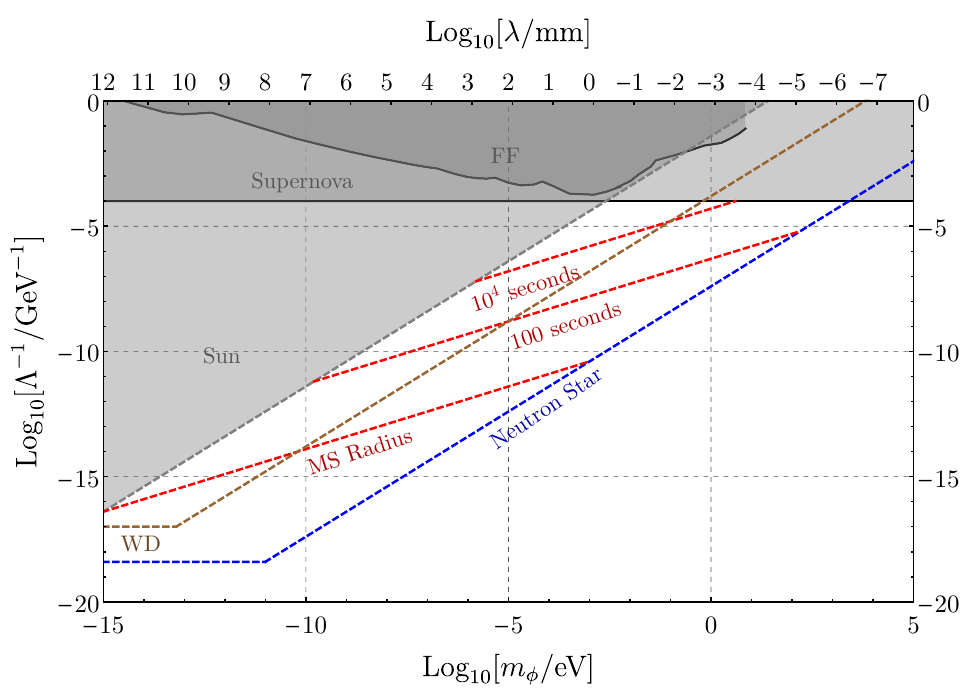
Figure 3 . Parameter space of scalars which interact with nucleons as φ 2 are excluded by supernova [51], measurements of solar neutrinos [31], and fifth-force measurements (see [52] and references within). Bubbles can be launched by a neutron star in the region to the left of the neutron star line (blue dashed). The bubbles will expand to a size with roughly main sequence star radius above the lower red dashed line, and 100 seconds (10 4 seconds) radius above the middle (upper) red dashed